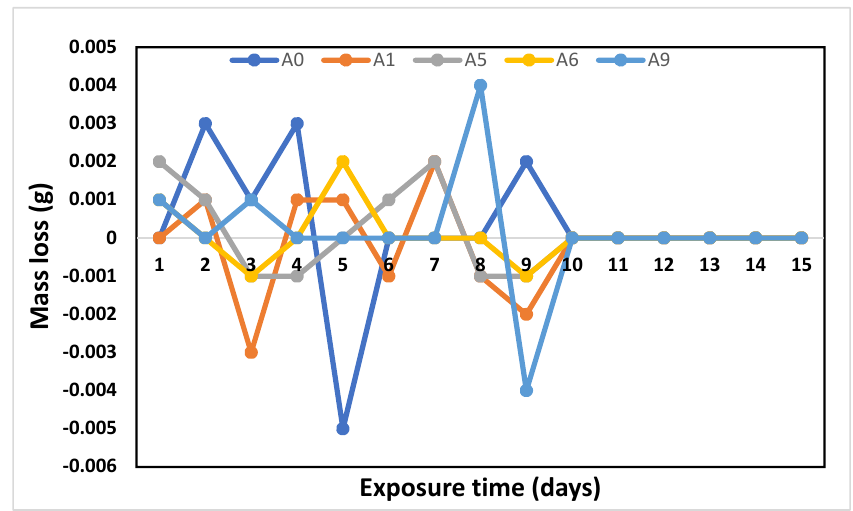
Figure 2. Mass changes of specimens against the time of exposure in 3.5 wt.% NaCl solution.